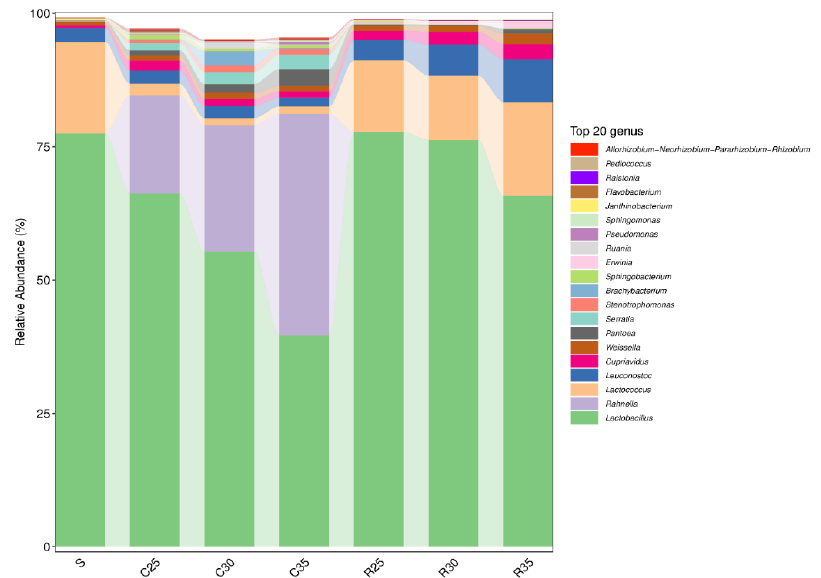
Figure 3. Bacterial community and relative abundance by genus for corn stover or rice straw silage mixed with soybean curd residue (S, soybean curd residue; C35/R35, soybean curd residue: corn stover/rice straw at 65:35; C30/R30, soybean curd residue: corn stover/rice straw at 70:30; C25/R25, soybean curd residue: corn stover/rice straw at 75:25).